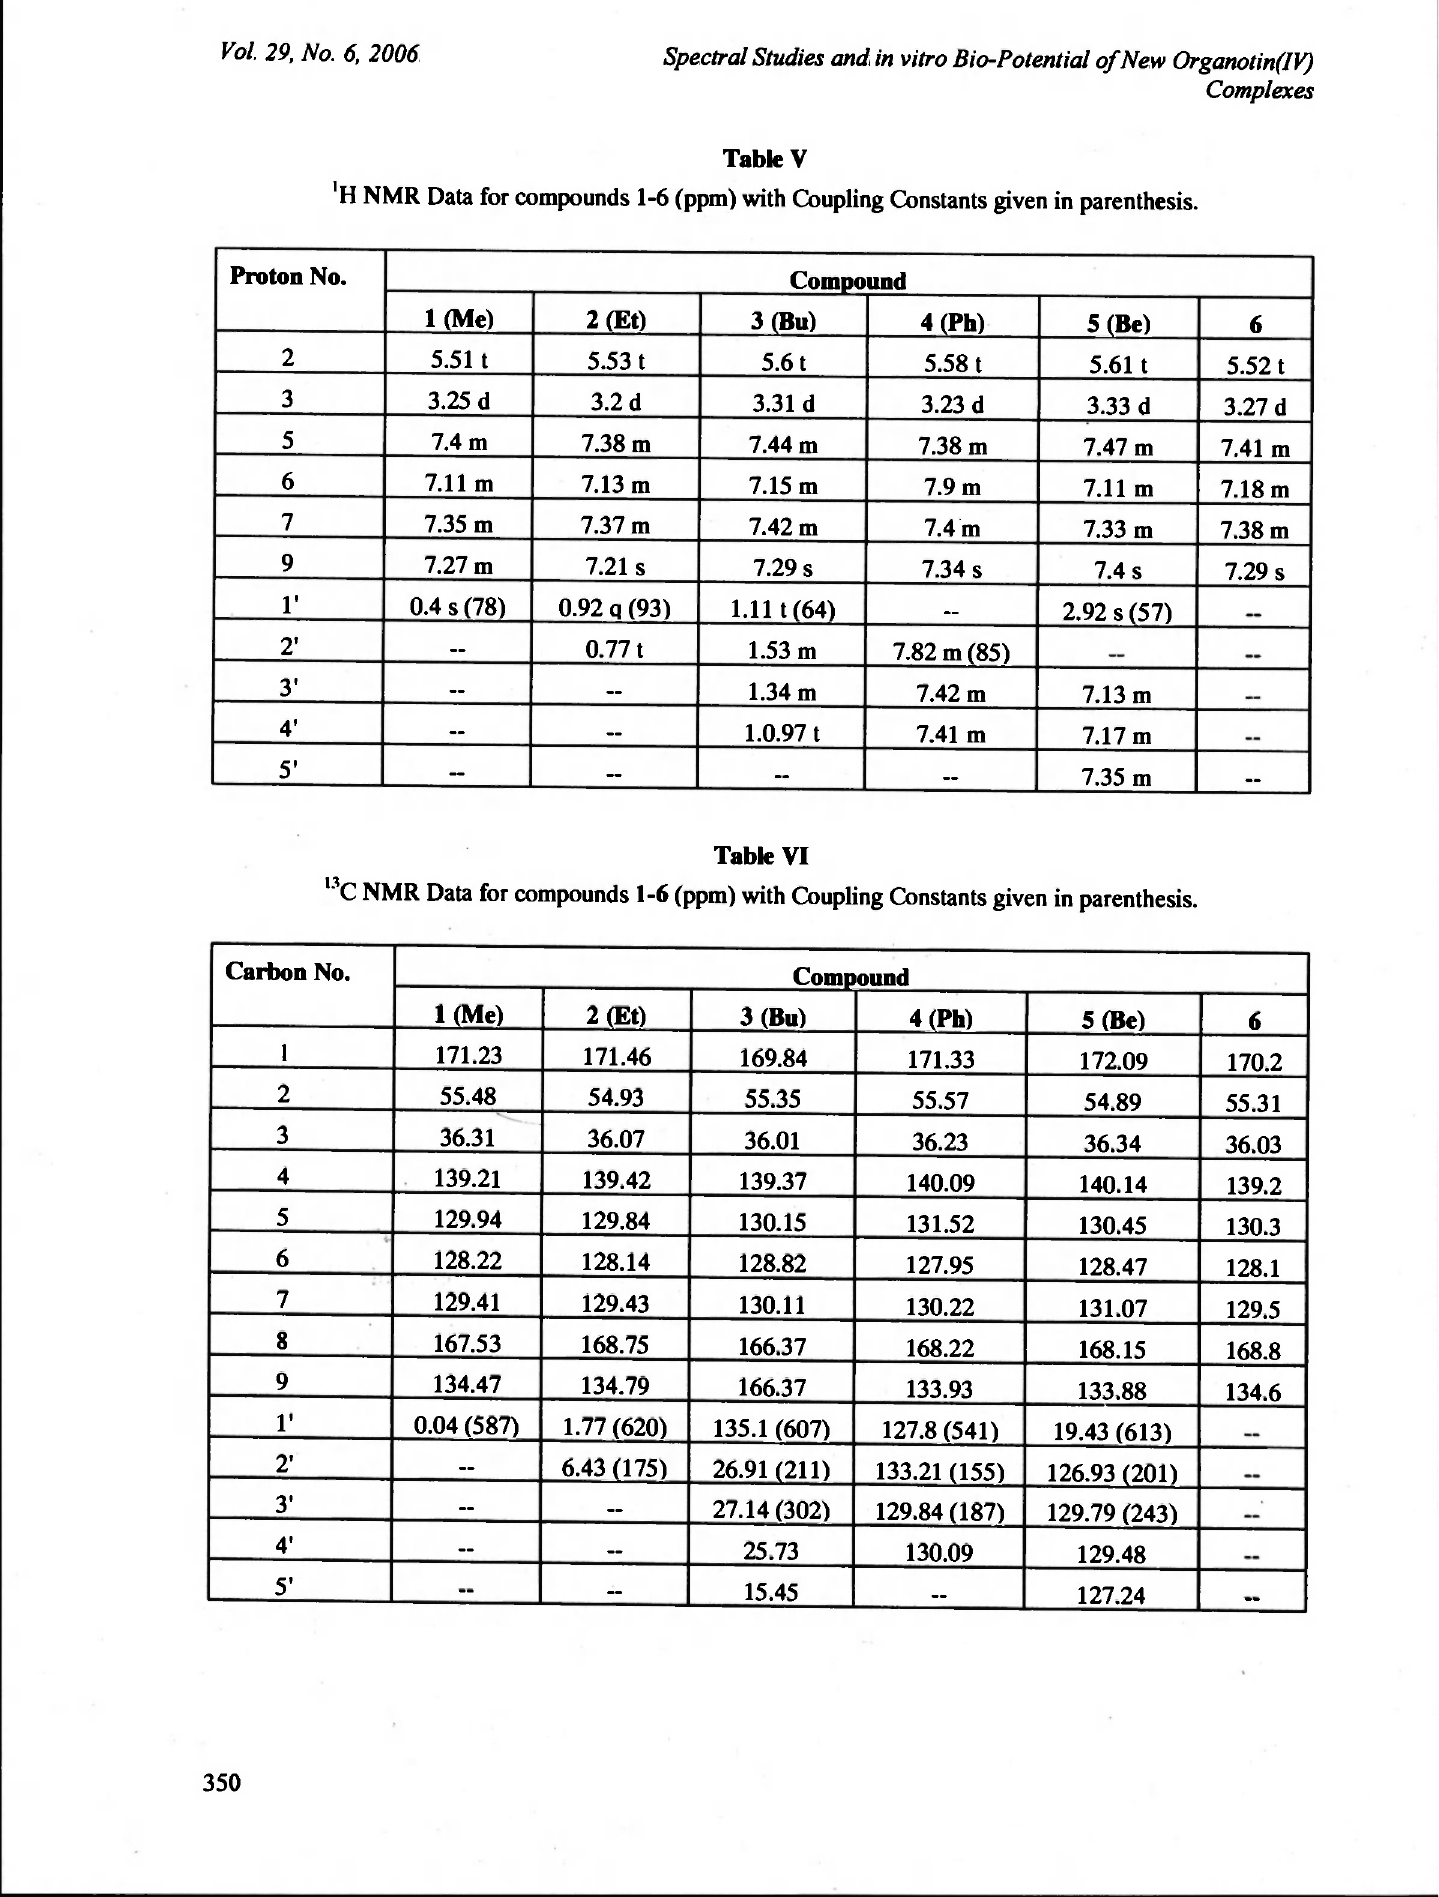
'H NMR Data for compounds 1-6 (ppm) with Coupling Constants given in parenthesis. Proton No.